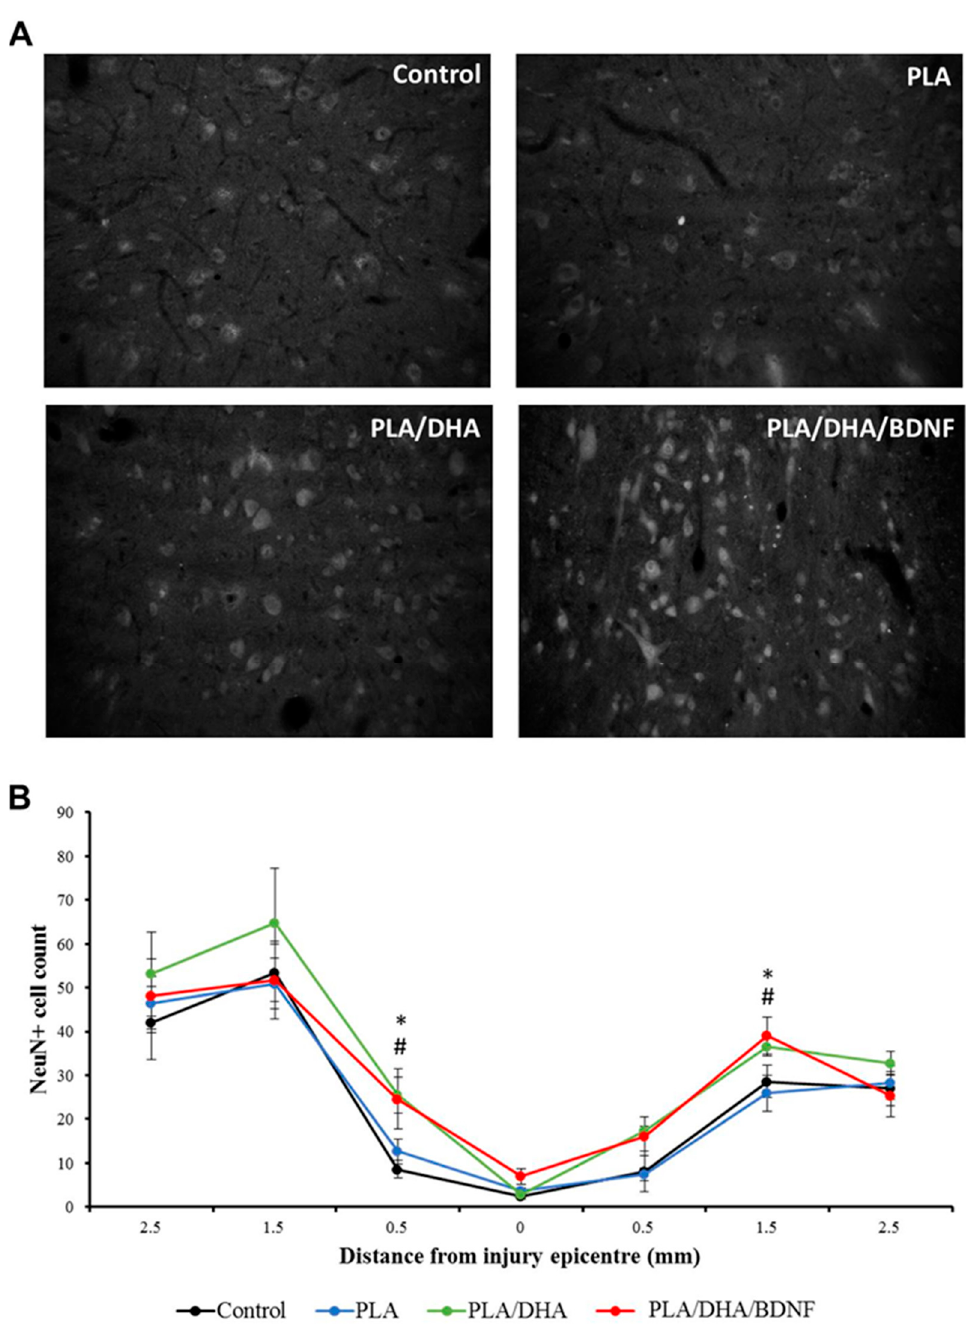
Figure 10. The immunolabeling of neuronal nuclei antigen (NeuN) from the spinal cords of SCI rats after different treatments ( A ), and the calculated number of NeuN-positive cells in the region rostral and caudal to the injury site ( B ). * p < 0.05 PLA/DHA/BDNF vs. control; # p < 0.05 PLA/DHA/BDNF vs. PLA. Serotonin (5-HT) is a neuromodulator secreted by supraspinal neurons that initiate